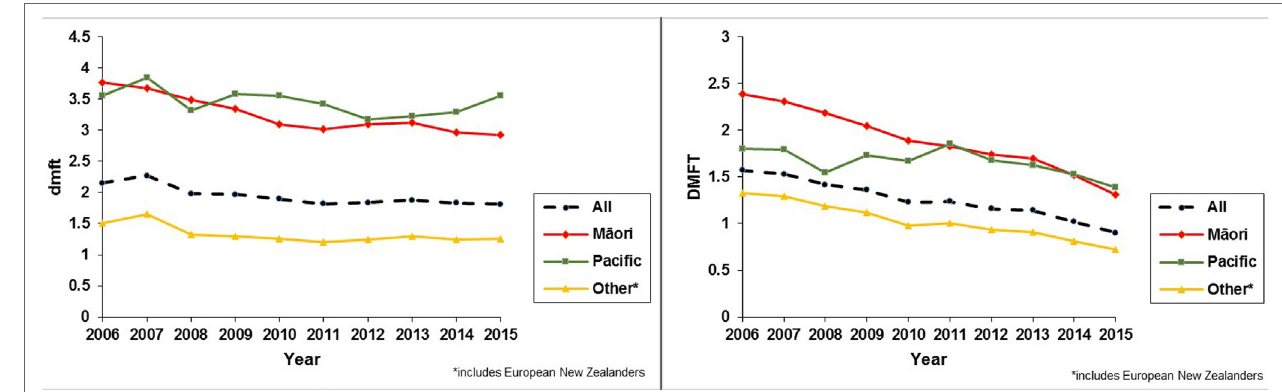
FiguRe 10 | Dental caries experience of 5-year-old and year 8 (12- to 13-year-old) New Zealand children from 2006 to 2015. The data in these line graphs represent cumulative dental caries experience among 5-year-olds (dmft) and 12- to 13-year-olds (DMFT) for all of New Zealand over a 10-year period